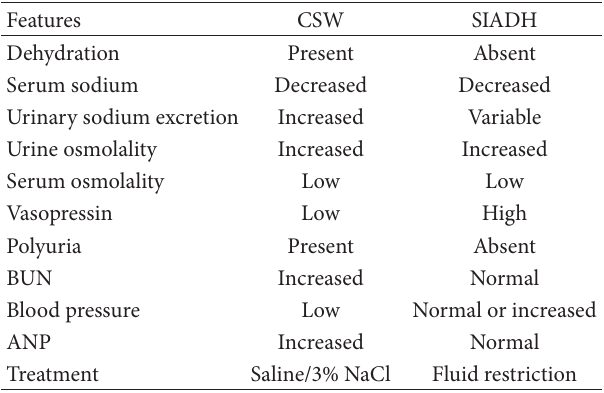
Table 1: Differences between CSW and SIADH [16, 17]